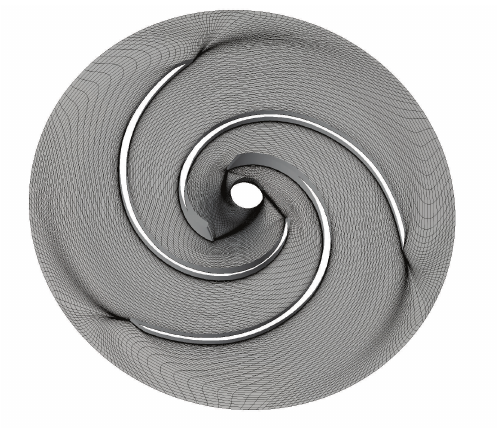
Figure 4: 3D view of the impeller grid.